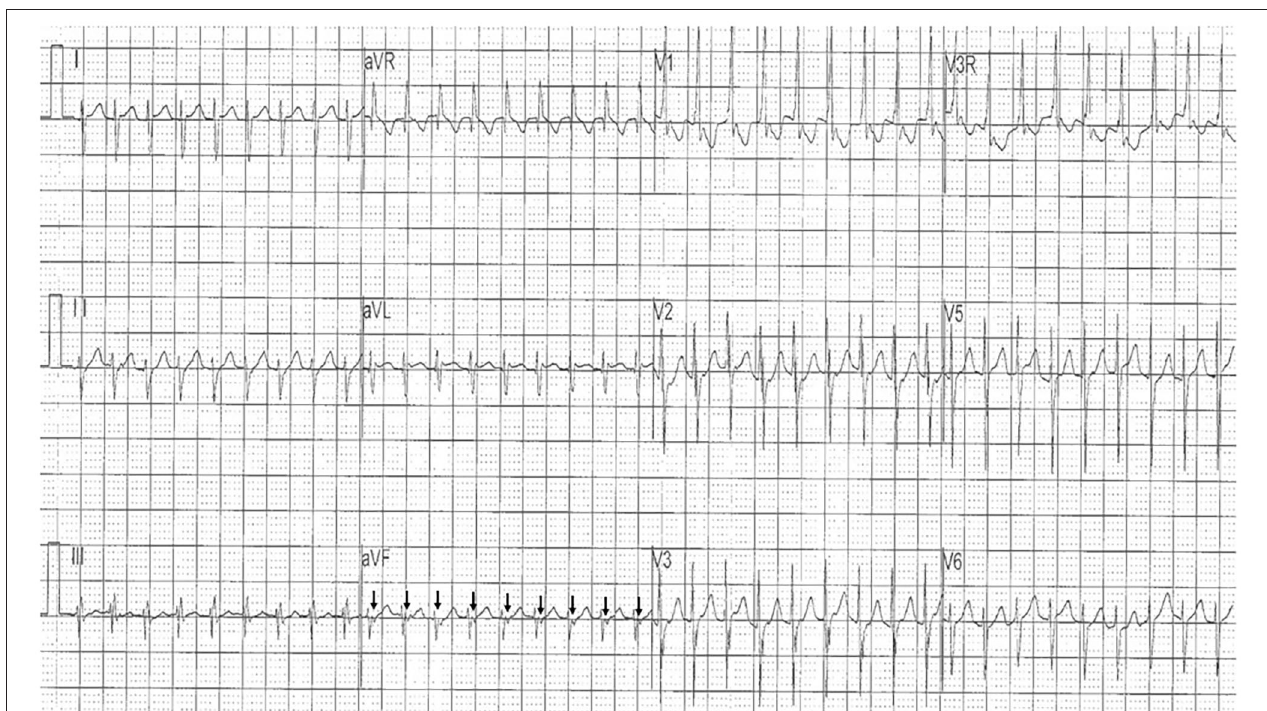
FIGURE 1 | The initial 12-lead electrocardiogram showed regular tachycardia with a heart rate of 210 bpm, a slightly wide QRS duration of 72ms, a superior QRS axis of 223 ◦ , and a right bundle branch block (RBBB) pattern. Reverse P ′ waves (arrow) were identified in lead aVF, indicating the presence of 1:1 ventriculoatrial (VA) retrograde conduction.